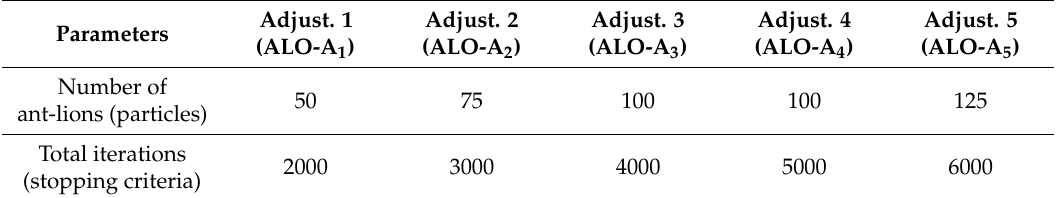
Table 4. Five different ALO adjustments considered for training ANN models along the prediction applications for the EEG time series (Figure 5) in the